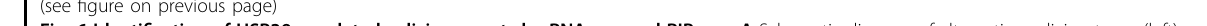
Fig. 6 Identi fi cation of USP39-regulated splicing events by RNA-seq and RIP-seq. A Schematic diagram of alternative splicing types (left) and pie chart depicting the proportions of different types of alternative splicing events in A2780 cells response to loss of USP39 (right). B Distribution of the reads count over intronic, intergenic, and exonic regions in A2780 cells with USP39 knockdown and control cells ( n = 3 biologically independent samples). C Global splicing ef fi ciency analysis at 5 ′ splicing site (5ss) and 3 ′ splicing site (3ss) in A2780 cells with and without USP39 depletion by shRNA. D Pie chart of the distribution of USP39 binding peaks based on RIP-seq data from A2780 cells ectopically expressing FLAG-tagged USP39. Most peaks mapped to introns (43.73%) and exons (28.52%). E Distribution of USP39 binding peaks recognized by RIPSeeker (eFDR < 0.05) and their fold enrichment (from RIP-seq). A large proportion of the peaks with higher fold change values are located at intron and exon regions, indicating the potential effects of USP39 on pre-mRNA splicing. F Normalized read distribution around the 3 ′ and 5 ′ splicing sites ( − 100 – 100 bp) was analyzed using RIP-seq data from A2780 cells with ectopic FLAG-tagged USP39 expression. RIP-seq signal exhibited a bimodal distribution through the intron- exon-intron model, and most signal distributed around the intron-exon and exon-intron junction, indicating the assistant role of USP39 in intron- exon splicing and exons junction. G Bubble diagram showing the results of GO enrichment analysis of 161 genes encoding transcripts bound by USP39 (eFDR < 0.05) in A2780 cells with FLAG-USP39 overexpression (from RIP-seq). H The overlap in transcripts identi fi ed as being bound by USP39 (from RIP-seq) and transcripts with decreased expression and decreased splicing ef fi ciency upon USP39 knockdown (from RNA-seq). I Semi- quantitative PCR validation of selected genes from ( F ). P value was obtained by Student ’ s t -test. Results represent the mean ± SD of three independent experiments. * P < 0.05, ** P < 0.01, *** P <